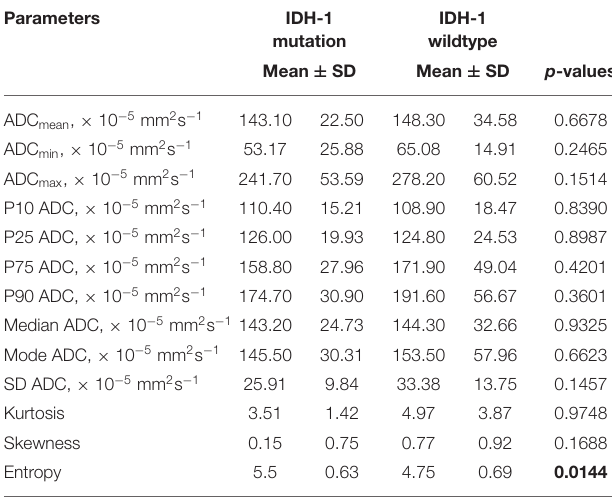
TABLE 4 | Comparison of DWI histogram profiles between low-grade gliomas with and without IDH-1 mutation.